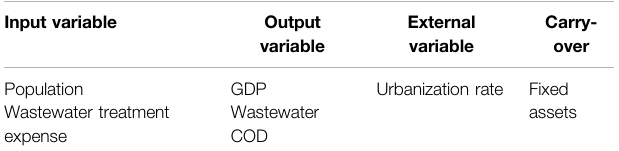
TABLE 1 | Input and output